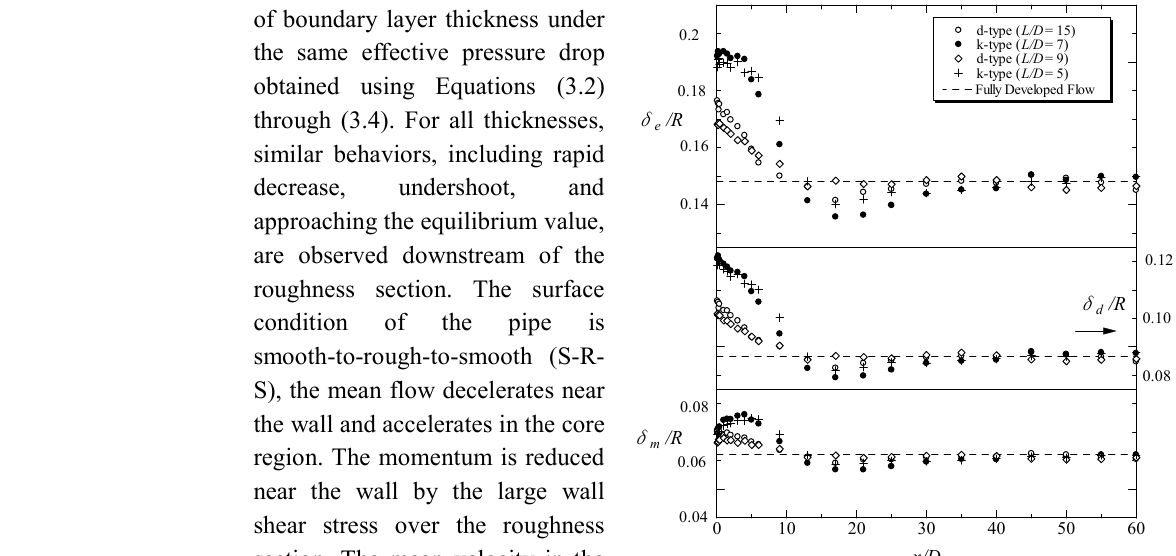
Fig. 9 Comparison of three types of boundary layer thickness under same effective pressure